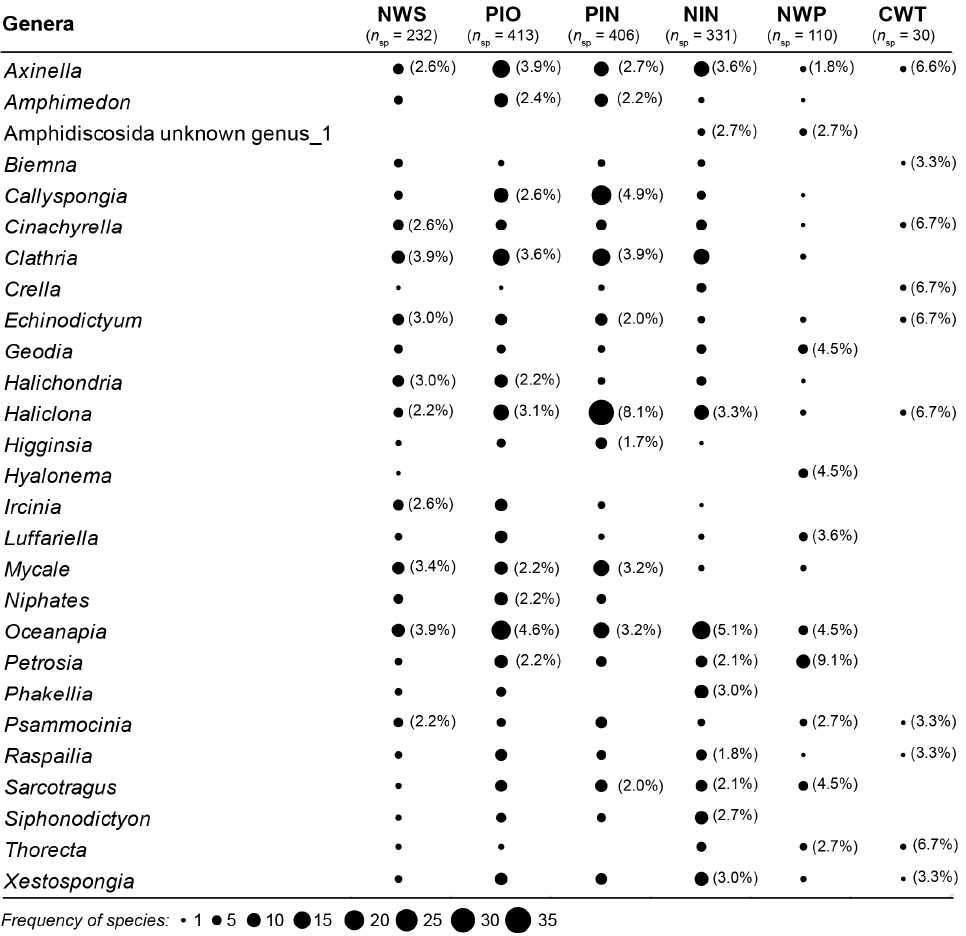
Figure 7. Representation of the 27 most speciose genera across the six IMCRA bioregions. Dot diameters represent frequencies of species within genera, and numbers within parentheses, where they appear next to a bubble, represent the percentage of species out of total species within bioregion (total species n is shown underneath abbreviated bioregion names; PIN–Pilbara Nearshore, PIO–Pilbara Offshore, NIN–Ningaloo, NWS–Northwest Shelf, NWP–Northwest Province and CWT–Central West Transition). Within each bioregion, dots with parentheses represent the ten most speciose genera for that bioregion.